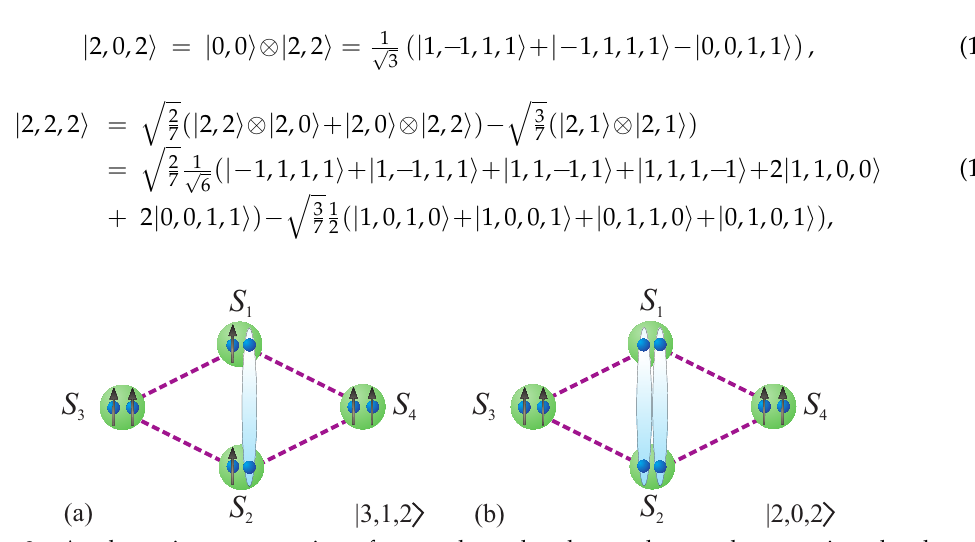
Figure 3. A schematic representation of two valence–bond–crystal ground states given by the eigenvectors: ( a ) | 3,1,2 (cid:105) ; ( b ) | 2,0,2 (cid:105) . Each spin-1 particle (large green sphere) is symmetrically decomposed within the valence–bond–solid picture into two spin-1/2 entities (small blue spheres), which either form a singlet (valence) bond schematically demarcated by ovals or are polarized into the magnetic-field direction as specified by up-pointing